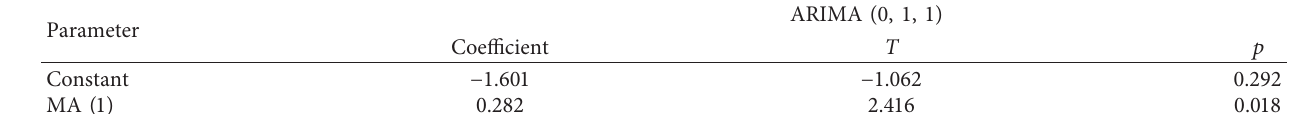
Table 7: ARIMA model parameter estimation